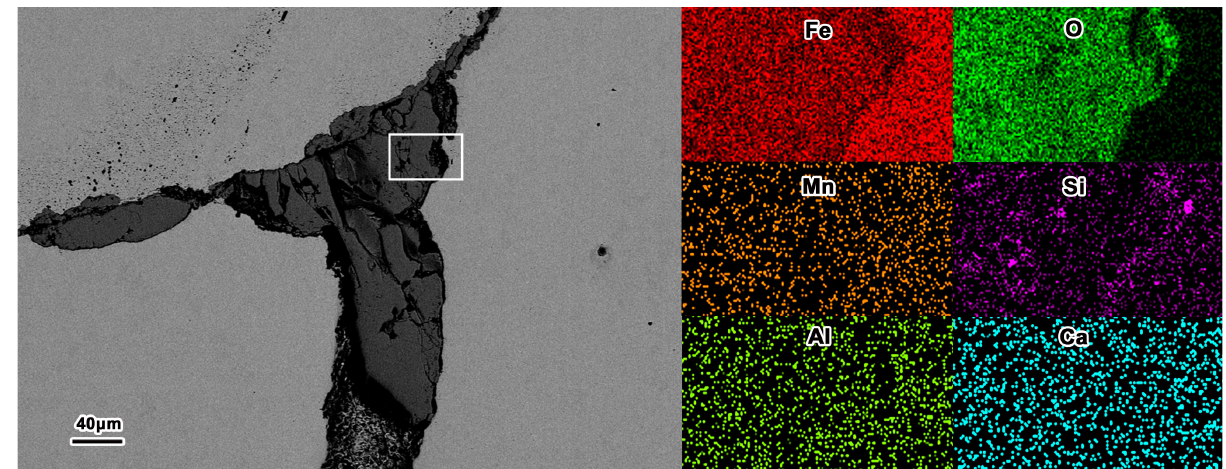
Figure 3: Metallographic structure near the reticular crack at (a) 100 × and (b) 500 × magnifications.